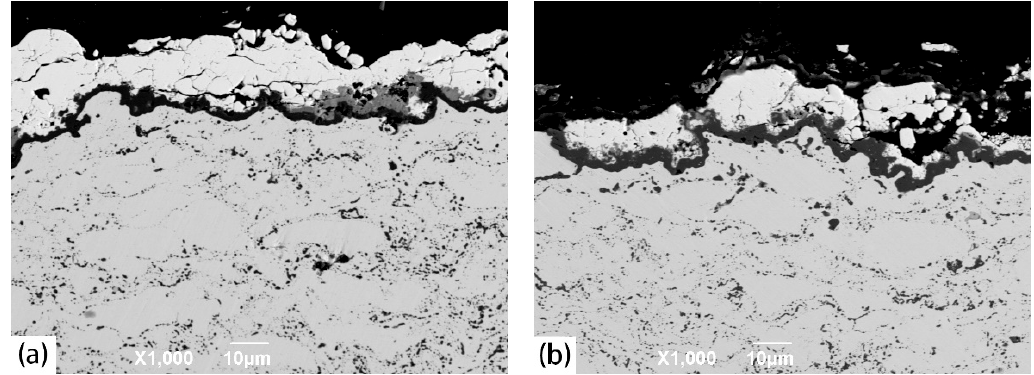
Figure 6. The section morphologies of the cracking modes of TBCs: ( a ) type A and ( b ) type B.